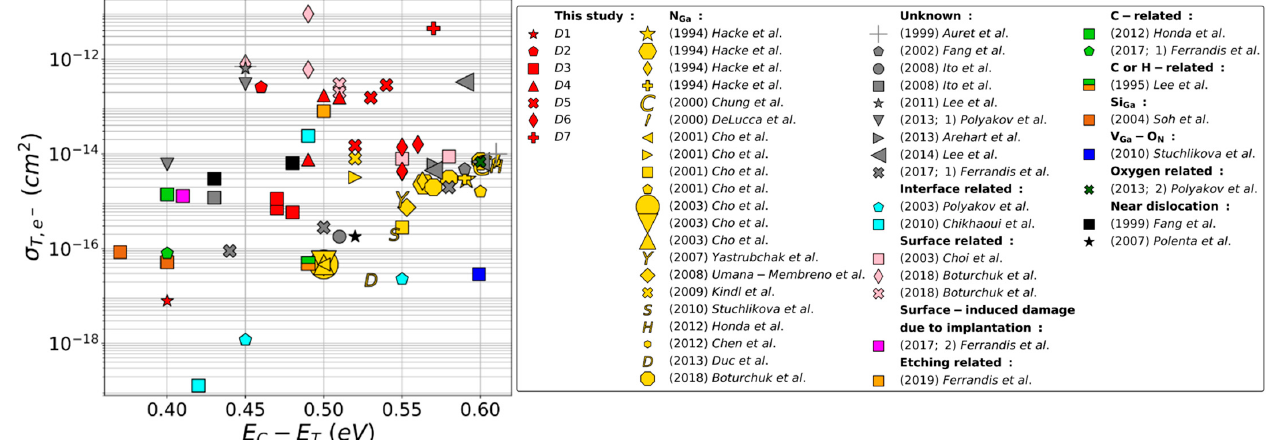
Figure 6. Extracted cross-section as a function of the trap energy from DLTS measurements from this study and the literature corresponding to point defects with an energy level between 0.36 eV and 0.61